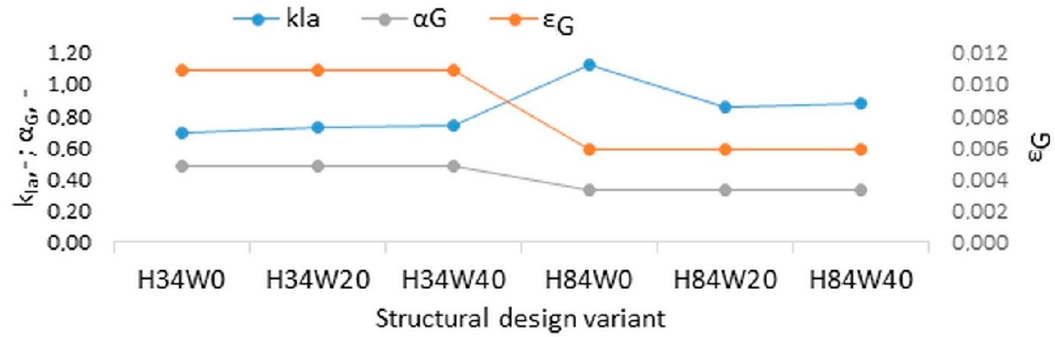
Figure 5. Gas holdup α G and ε G and oxygen volumetric mass transfer coefficient k La for different structural design variants of the reactor.